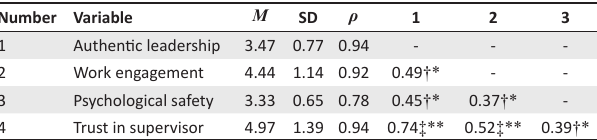
TABLE 2: Correlation matrix including means, standard deviations and reliabilities.